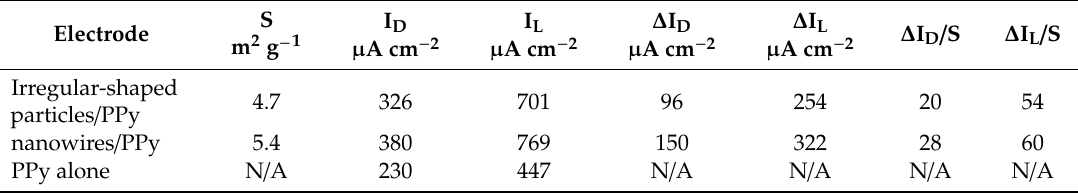
Table 1. Comparison between irregular-shaped CaMn 2 O 4 powder and CaMn 2 O 4 nanowires for Brunauer-Emmett-Teller (BET) specific surface area, increase in dark- and photo-current with regard to control electrode; BET specific surface area (S), dark current (I D ), photo-current (I L ), increase in dark current with respect to control ( ∆ I D ), increase in photo-current with respect to control ( ∆ I L ).